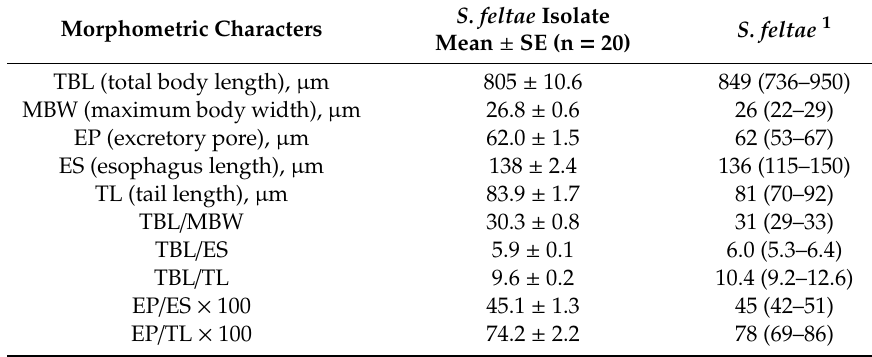
Table 2. Identification of S. feltiae isolate based on morphological characteristics of infective